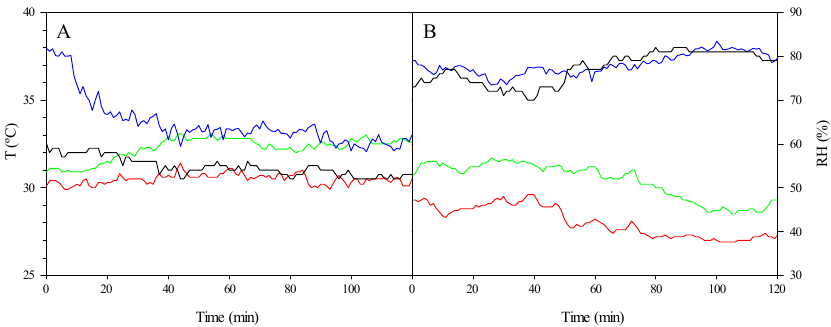
Figure 12. Temperature (indoor, green, and outdoor, red) and relative humidity dynamics (indoor, blue, and outdoor, black) during roof and shaded ventilation (V + S) tests between 13:00 and 15:00 h (A: test 5; B: test 12).